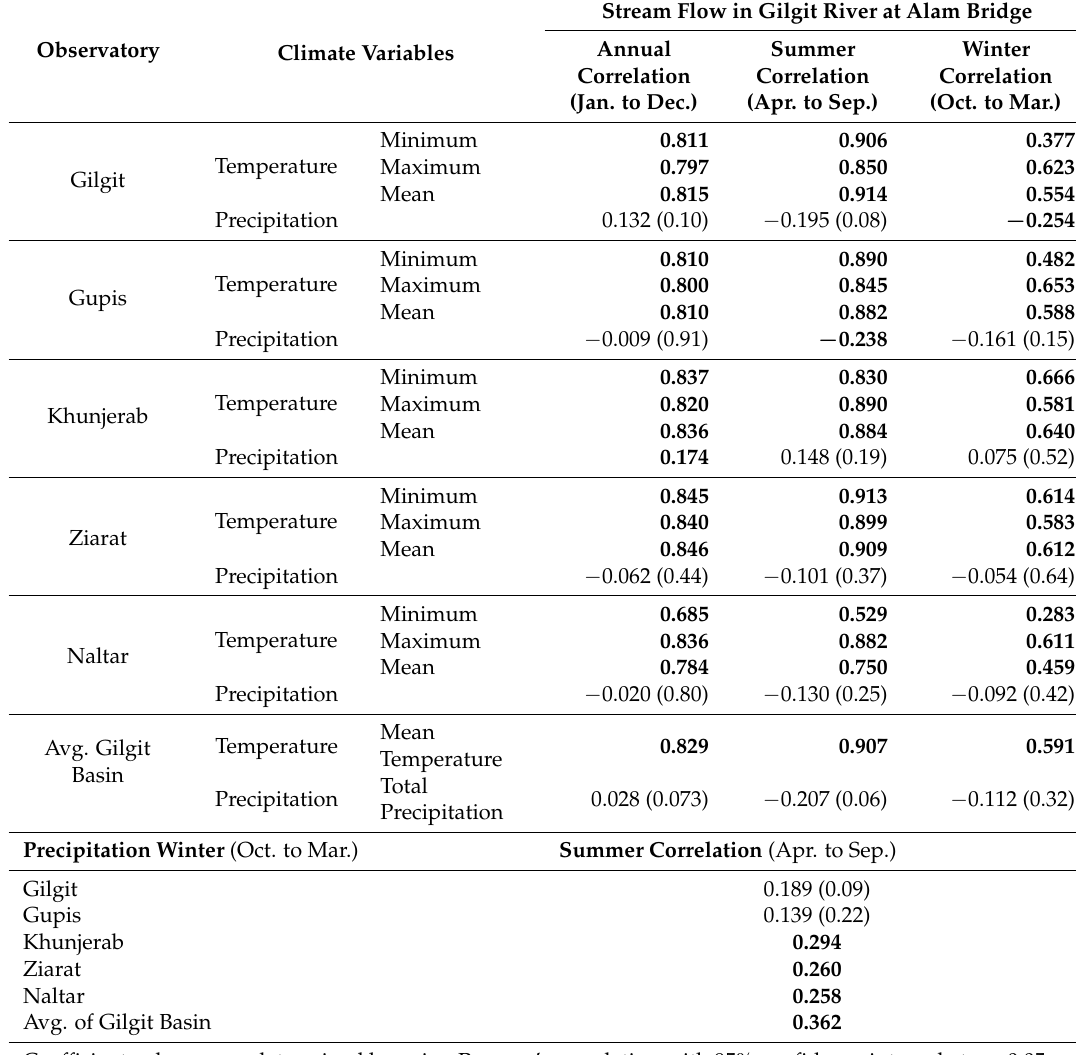
Table 4. Annual and seasonal correlation coefficients between stream flow, Gilgit River Basin at Alam Bridge (2001–2013), and mean monthly climate data (temperature and precipitation) in the Gilgit Basin climate stations